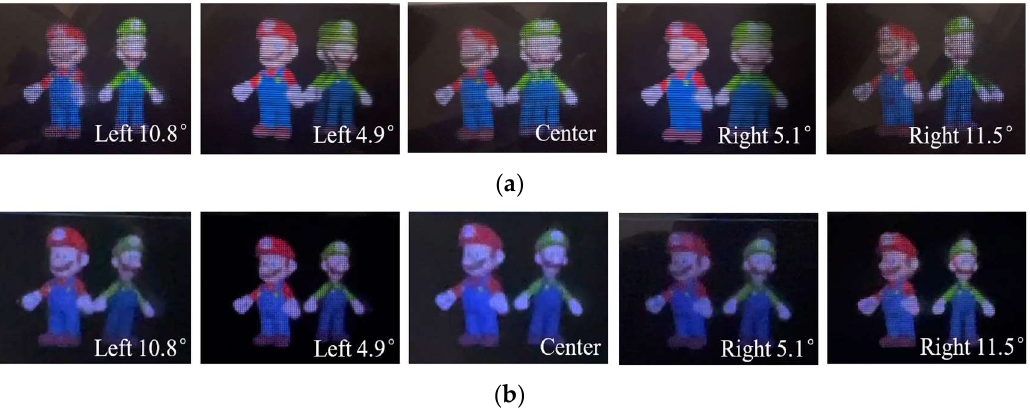
Figure 10. Captured 3D images for ( a ) the conventional EIA and ( b ) the FEP-EIA with L = 250 mm.